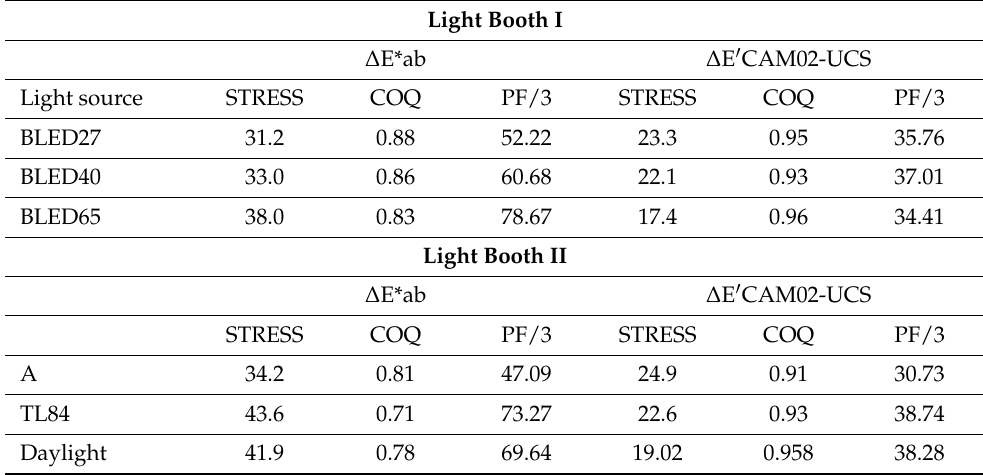
Figure 10. Performance of color difference formula in term of STRESS. Left: light booth I, right: light booth II. In the figure, BLED65, BLED40, and BLED27 represent the light sources with nominal CCT 6500 K, 4000 K, and 2700 K respectively for light booth I; and Daylight (Simulator D65), TL84 (Tri-band fluorescent tube), and A (Tungsten lamp) represent the light sources with nominal CCT 6500 K, 4000 K, and 2700 K respectively for light booth II. Table 3. Performance of color difference formulas in term of STRESS, COQ, and PF/3. In the table, BLED65, BLED40, and BLED27 represent the light sources with nominal CCT 6500 K, 4000 K, and 2700 K respectively for light booth I; and Daylight (Simulator D65), TL84 (Tri-band fluorescent tube), and A (Tungsten lamp) represent the light sources with nominal CCT 6500 K, 4000 K, and 2700 K respectively for light booth II.